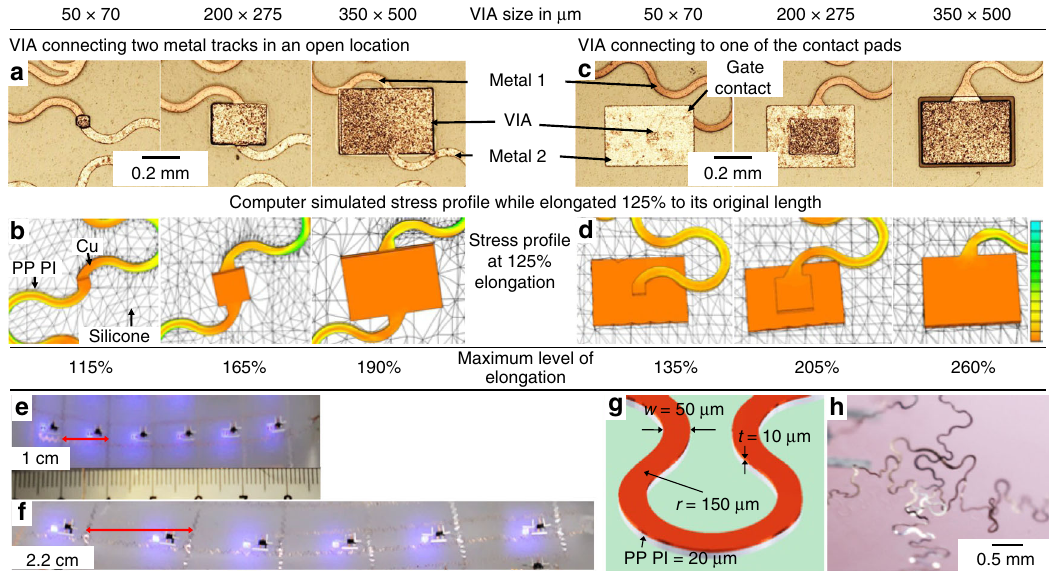
Fig. 3 VIA designs affecting the maximum level of elongation. a , b VIAs connecting bottom and top metal tracks in an open location and c , d VIAs connecting a metal track to one of the contact pads of a SMD. Optical microscope photographs of the VIAs ( a , c ) and computer simulated stress pro fi le in the metal tracks while elongated 125% to its original length ( b , d ). The dimensions of the VIAs and corresponding maximum level of uniaxial elongation are shown in the table. e , f Results of the stretching tests using a stress adaptive meander shaped metal track in unstretched condition ( e ) and while elongated to 220% (up to 260%) to its original length ( f ). g Schematic dimensions of the meander shaped metal tracks and h image of a failure mode in the SPCB using current design. VIA vertical interconnect access, PP PI photo-patternable